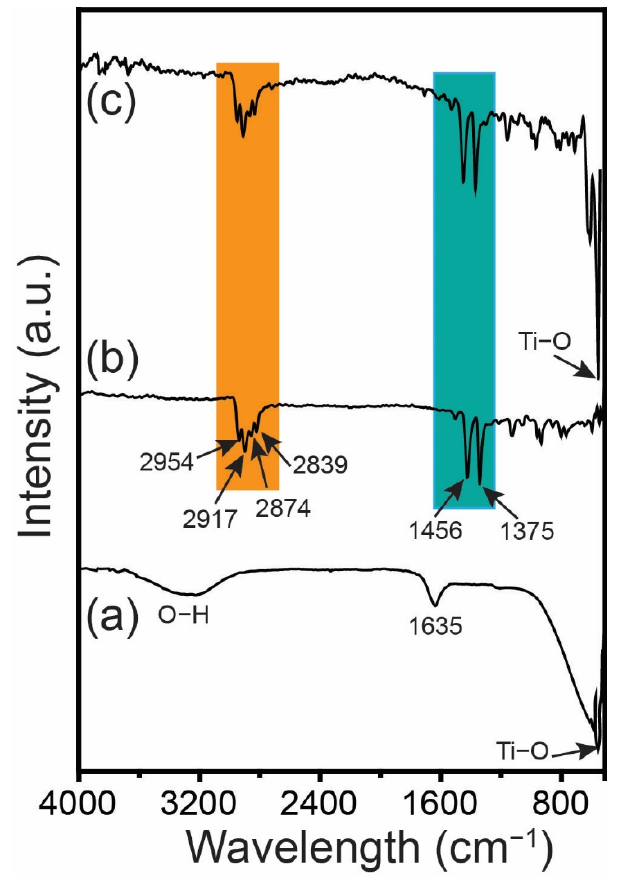
Figure 7. FTIR spectra of ( a ) TiO 2 NPs, ( b ) PPM, and ( c ) PPM + TiO 2 NPs.